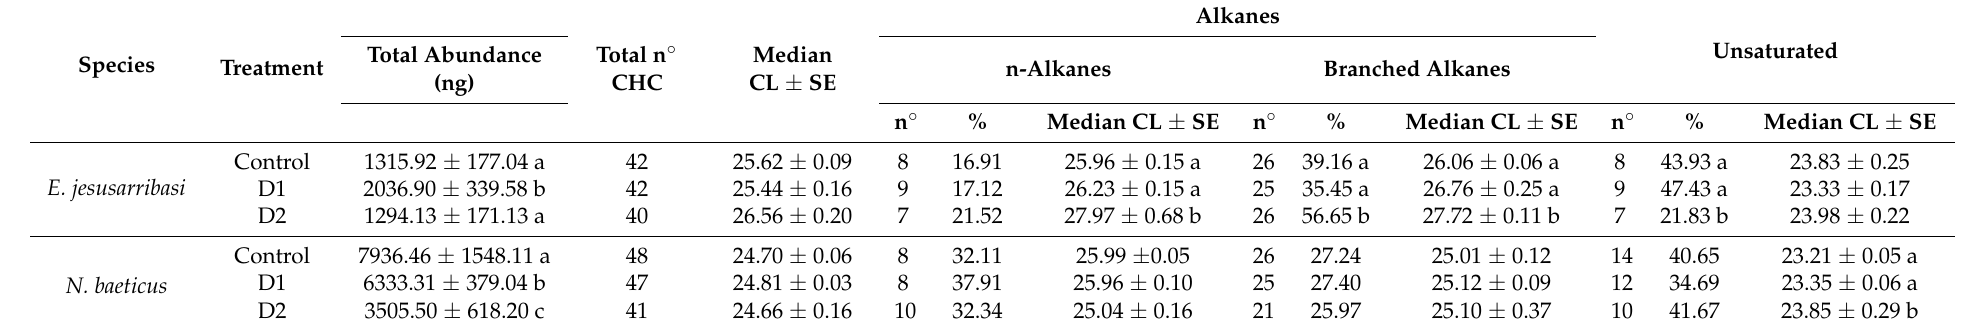
Table 1. Total abundance of cuticular hydrocarbons (CHC), number of CHC compounds, median chain length (CL) (total and for each CHC main class) and number and proportion of compounds of each class (number of CHC of the corresponding class over the total) for the studied species. D1: individuals from the water control exposed to desiccation, D2: individuals from the prior desiccation exposed to a subsequent desiccation